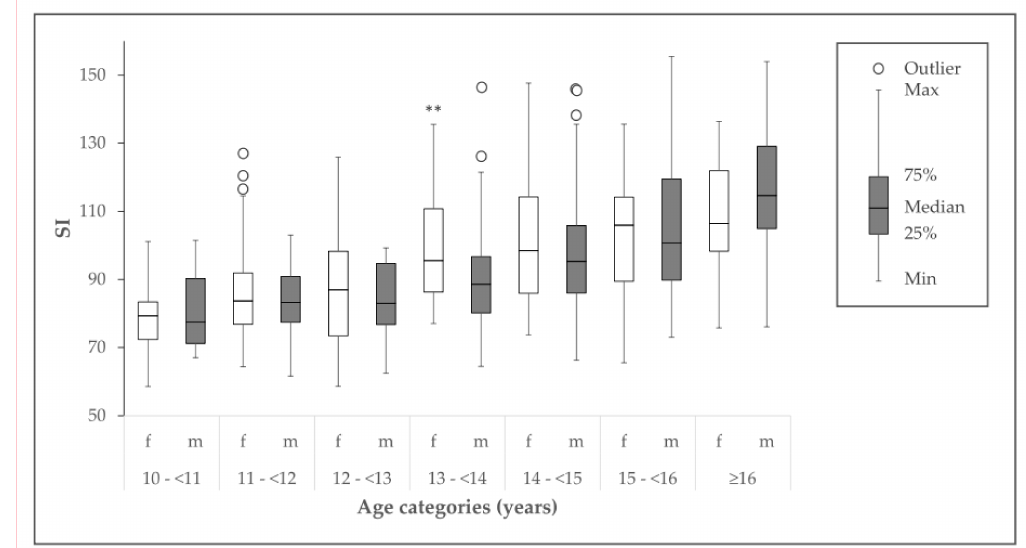
Figure 1. Calcaneal sti ff ness index (SI) of di ff erent age categories of boys (m) and girls (f). ** Significantly di ff erent from boys ( p < 0.01).